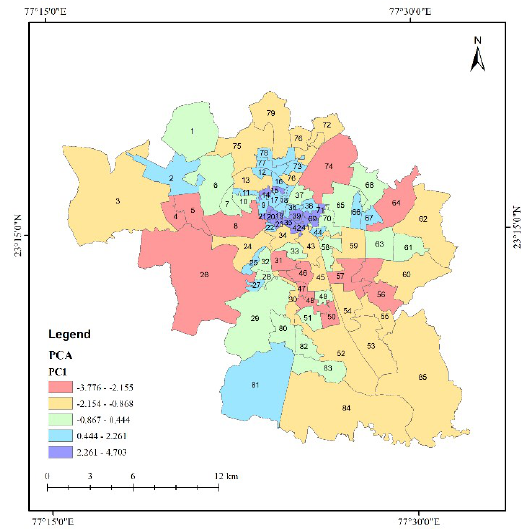
Figure 7 . Map of the ward-wise scores of PC1